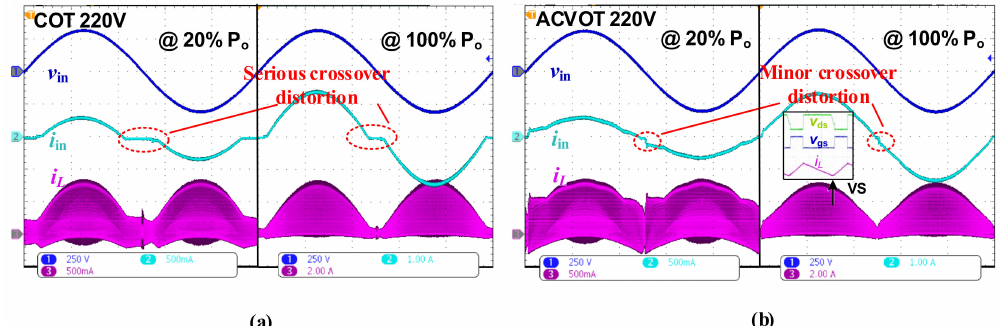
Figure 13. Waveforms at 110 Vac with 20%/100% load: ( a ) under the COT control; ( b ) under the ACVOT control.